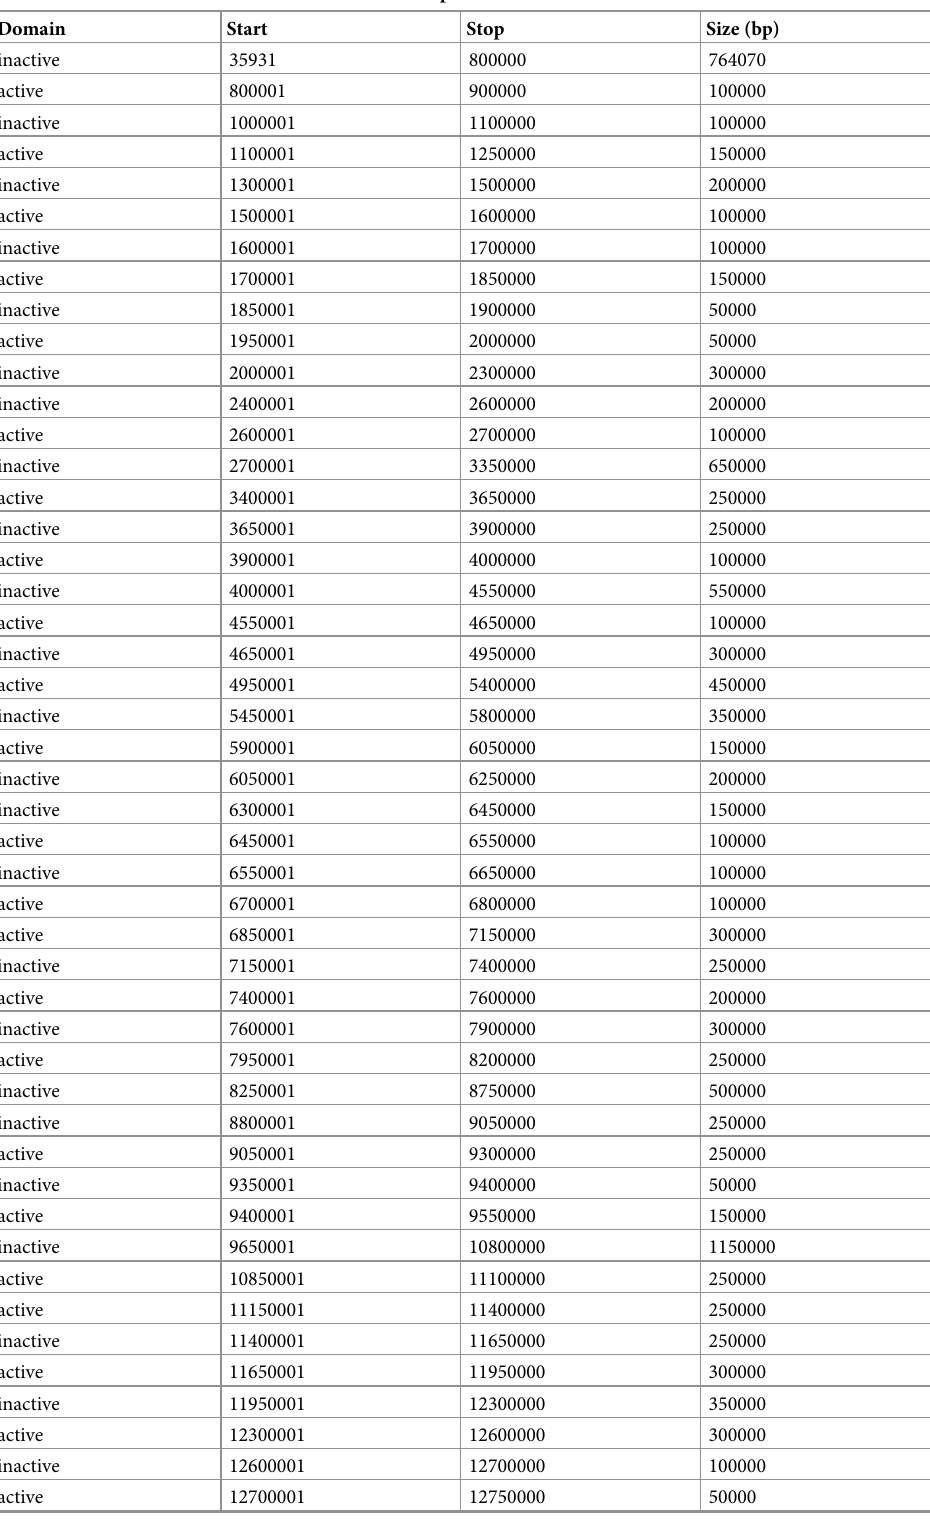
Table 3. Ch7 Active and inactive chromatin domains paint